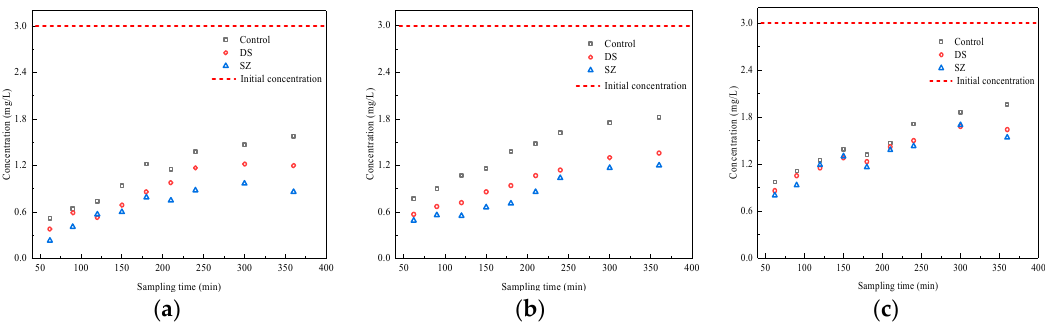
Figure 4. Concentration of NH 4+ -N using bioretention systems with the Control column, DS column, and SZ column under 1a ( a ), 5a ( b ), and 10a ( c ) rainfall intensities.